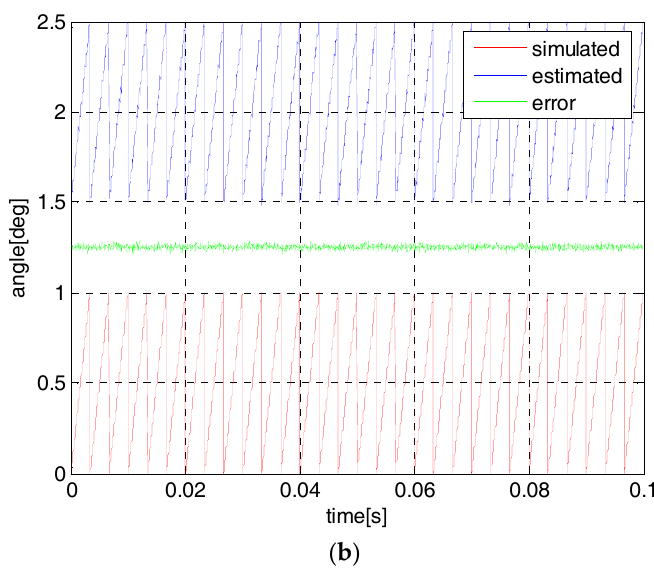
Figure 9. The simulated angle and its estimation at 9000 rpm by using one ‐ step observer ( a ) and two ‐ step observer ( b ).